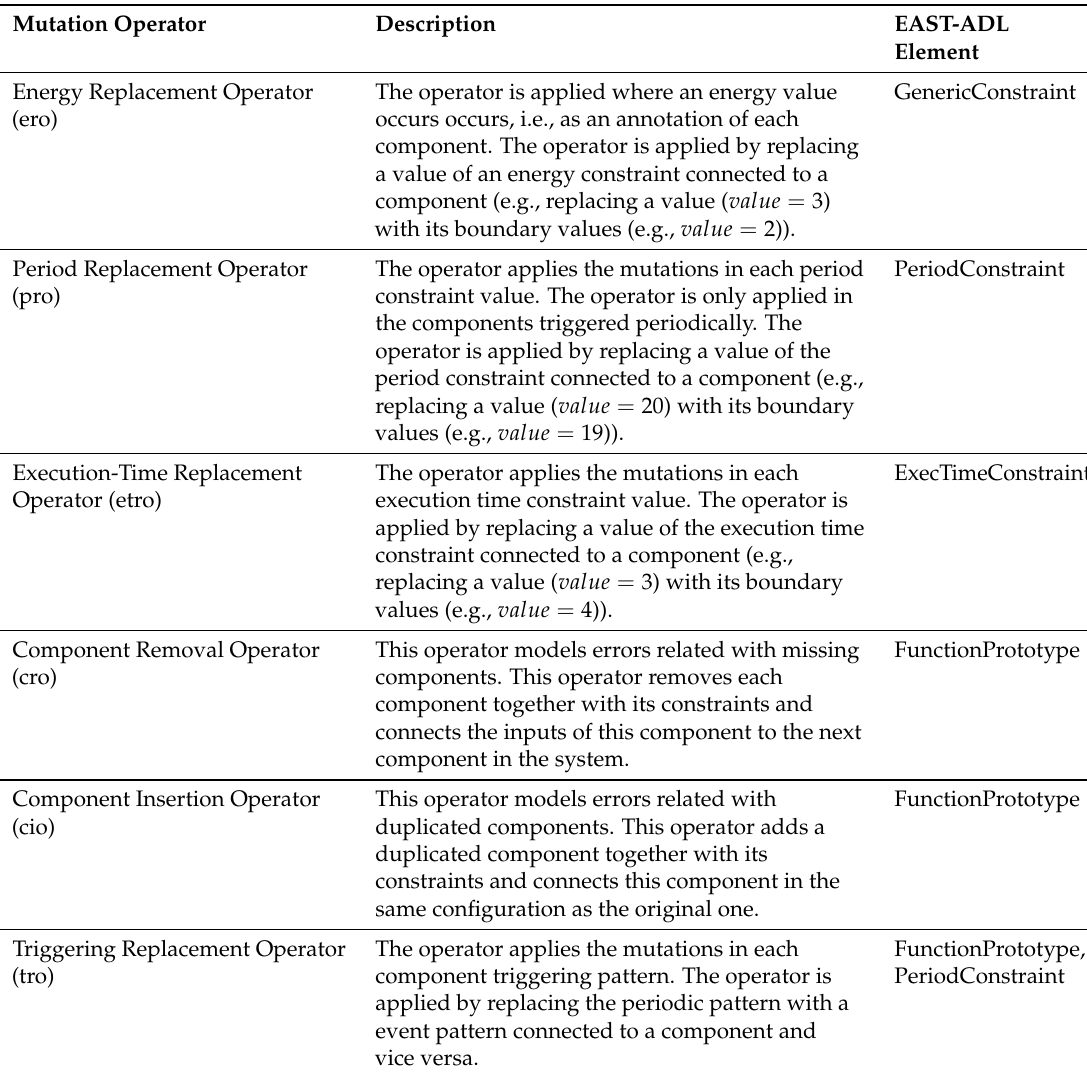
Table 1. Description of each mutation operator and the elements in EAST-ADL that are